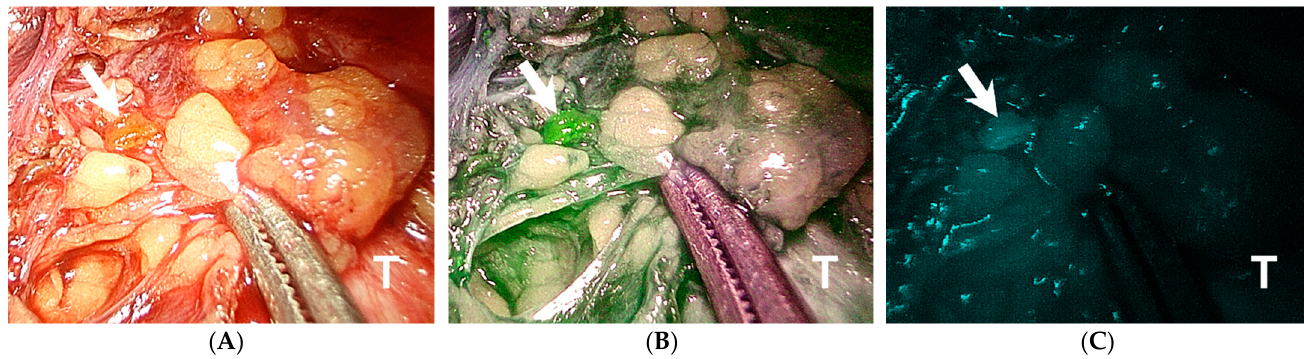
Figure 1. A small left inferior parathyroid gland (arrow) is overlooked during the initial visual inspection ( A ). After indocyanine green injection, the gland is identified by the distinctive fluorescence that contrasted itself from the surrounding soft tissue ( B , C ). T, trachea.